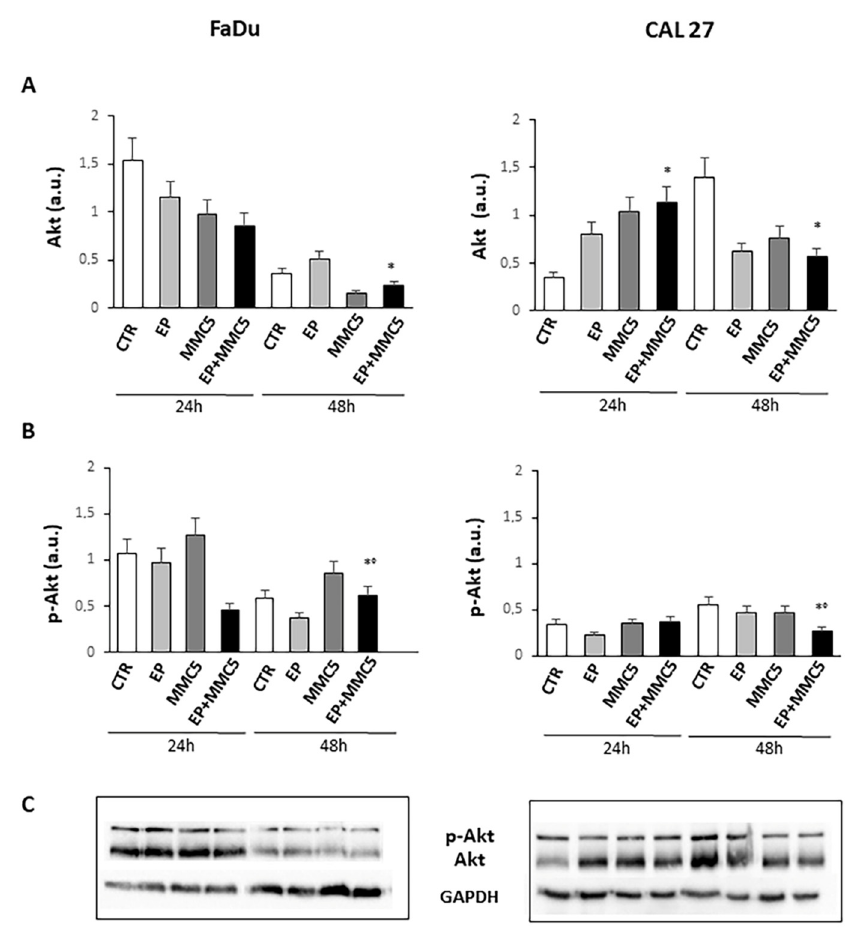
Figure 12. Evaluation of Akt and phospho-Akt. The bar graphs show the quantification of the relative densitometry of Akt ( A ) and phospho-Akt ( B ) in the FaDu (left panel) and CAL 27 cells (right panel). Each protein is normalized to GAPDH. Data are expressed as the mean ± SD of three independent experiments. * p ≤ 0.05 vs. control; ◦ p ≤ 0.05 compared to MMC. ( C ) Representative Western blot analysis of Akt and phospho-Akt in the FaDu (left panel) and CAL 27 cells (right panel). The GAPDH determination was used as load control. Not-cropped Western blot figures are available in Figure S4.